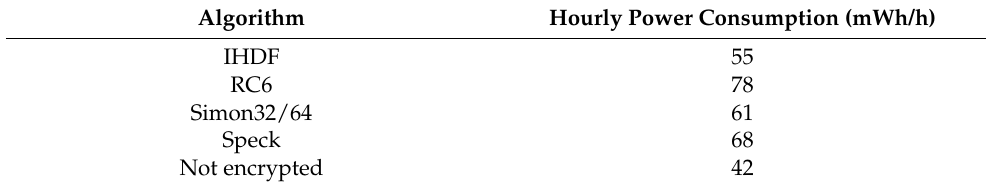
Table 5. Hourly power consumption of different algorithms.